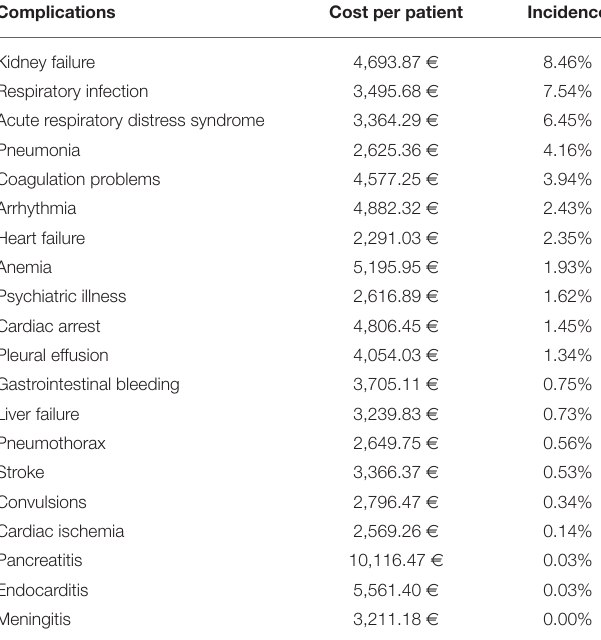
TABLE 3 | Cost of